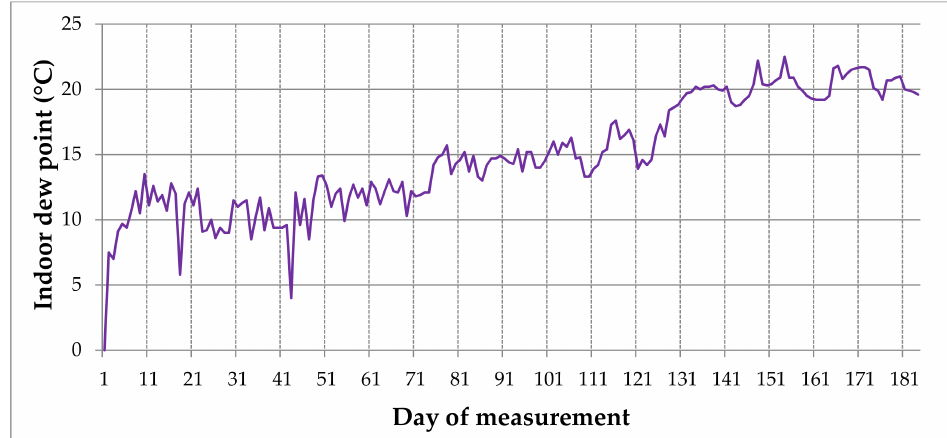
Figure 6. Daily variations of indoor dew point during the measurement period.